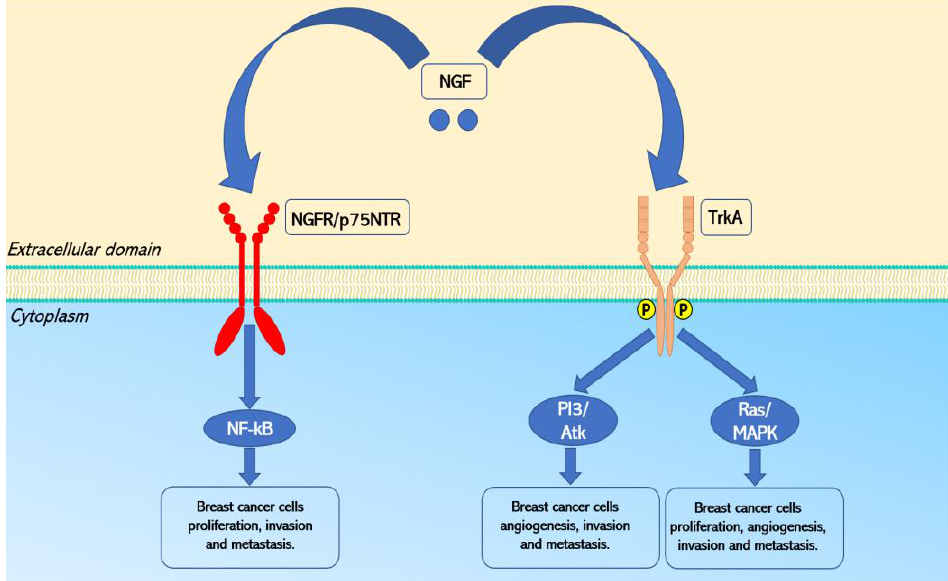
Figure 2. Signaling pathways activated by NGF in breast cancer. Note. NF- κB, Nuclear factor - κB; PI3K, Phosphatidylinositol-3-kinase; Atk, serine-threonine kinase; Ras, Rat sarcoma virus proteins; MAPK, Mitogen activated protein kinase.